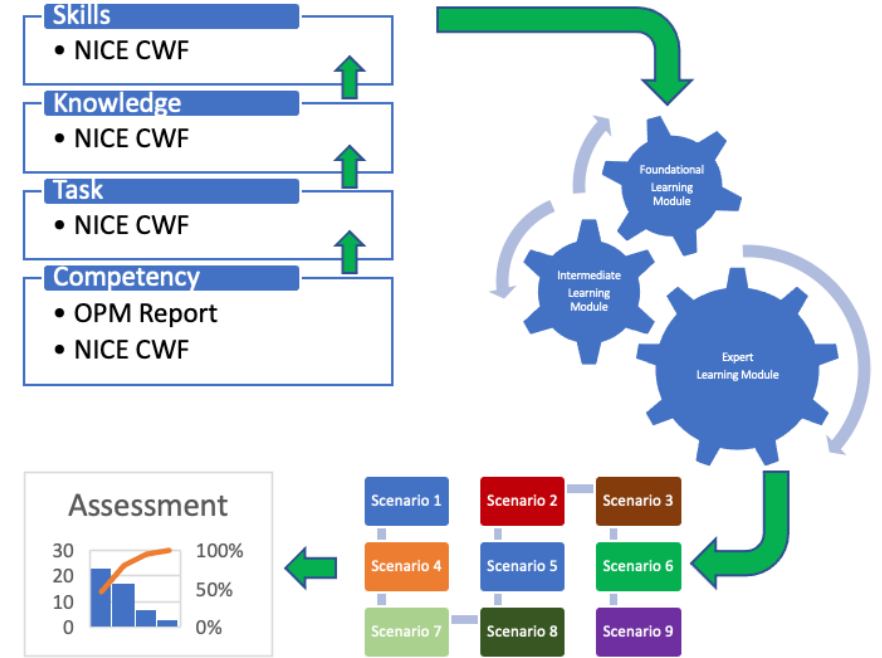
Figure 1. Scenario-Based Learning